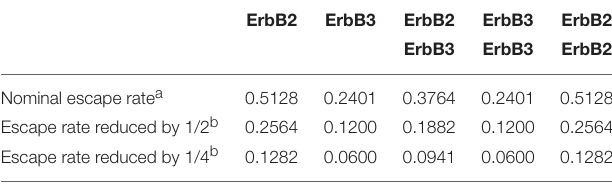
TABLE 1 | Model parameters of receptor monomers and dimers. TABLE 2 | Escape rates of receptor monomers and